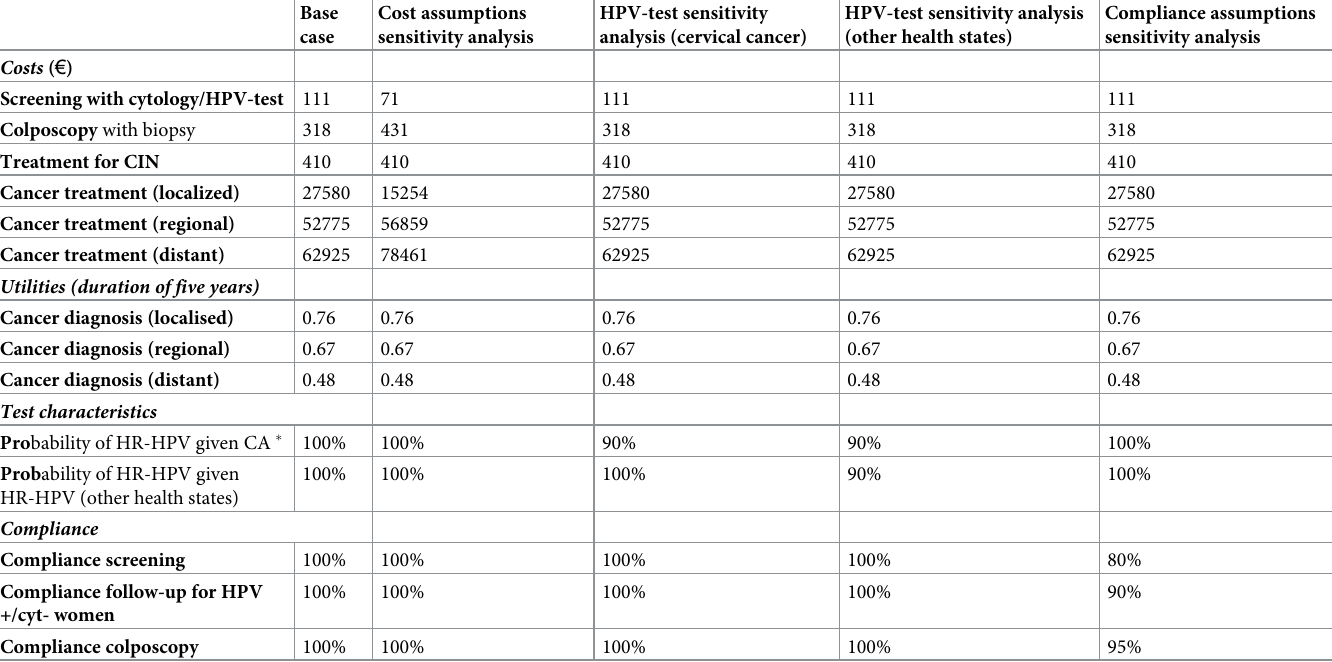
Table 1. Selected model inputs for key assumptions in base case analysis and sensitivity